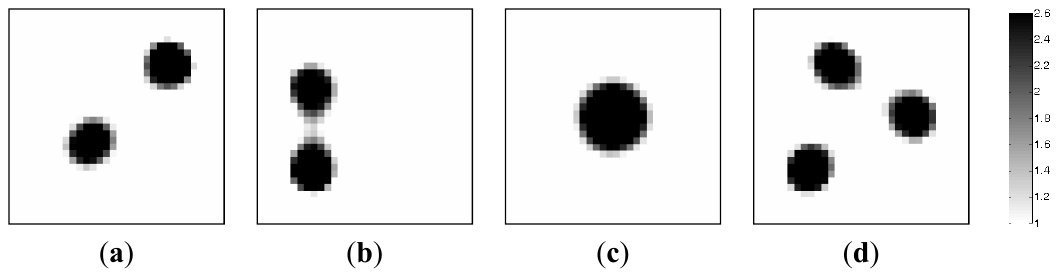
Figure 7. Reconstructed images by the MMVDR algorithm.